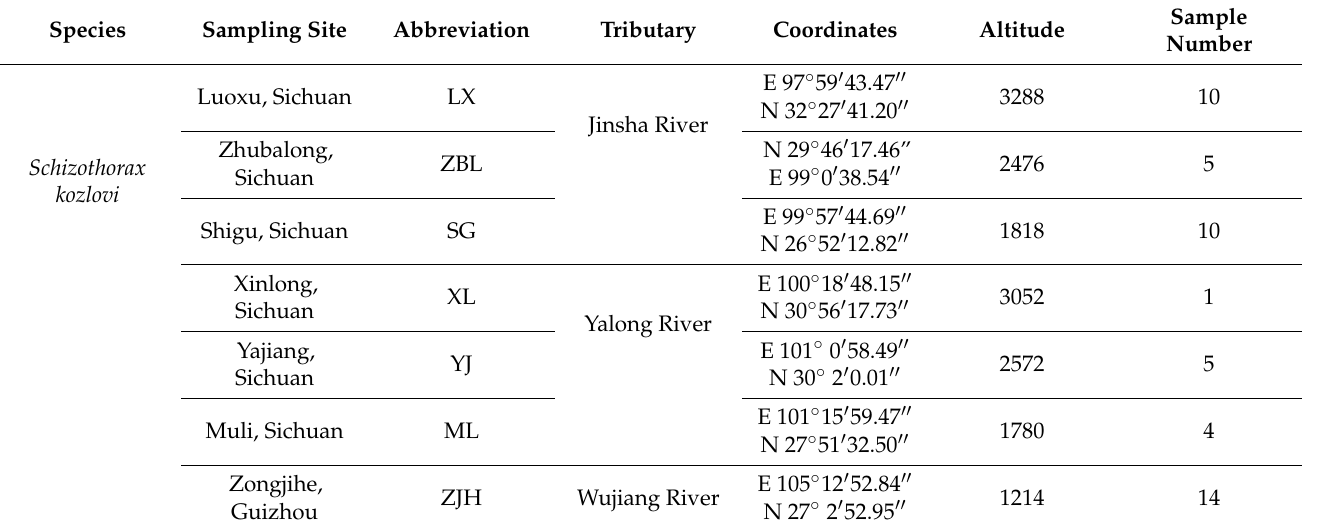
Figure 1. Map of sampling sites. LX, Luoxu; ZBL, Zhubalong; SG, Shigu; XL, Xinlong; YJ, Yajiang; ML, Muli; ZJH, Zongjihe. Table 1. Specimens for